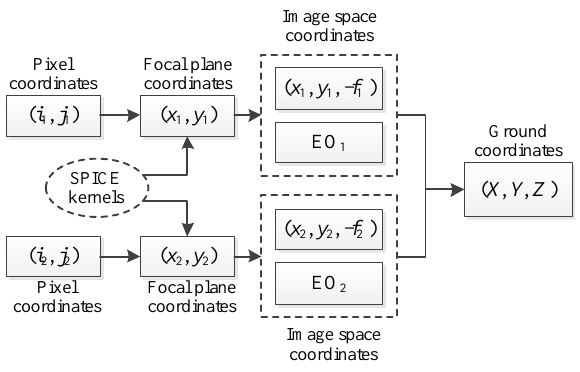
Figure 7. The processing procedure of forward intersection for pushbroom images